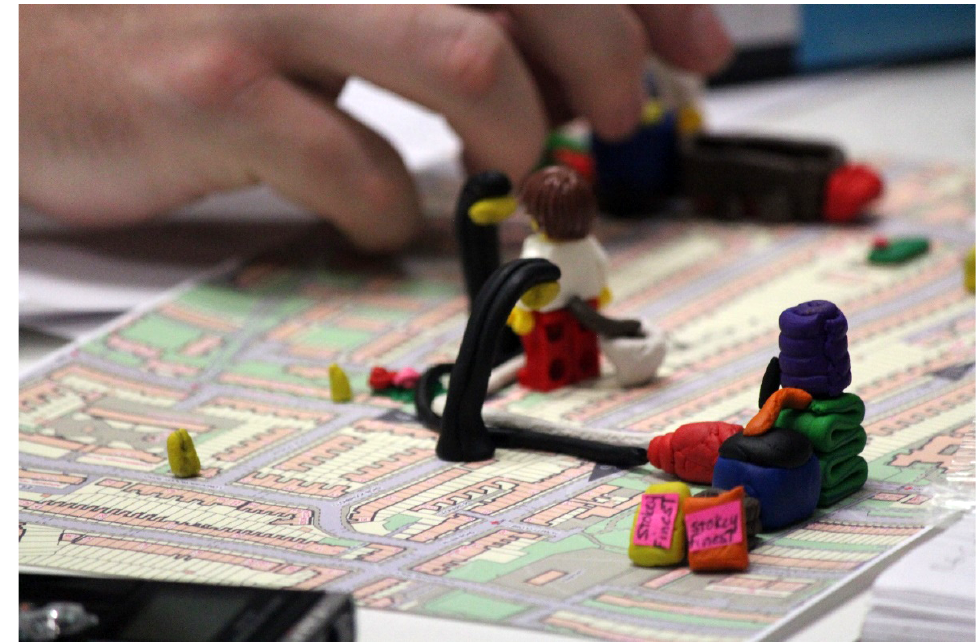
Figure 3. “Silvia Does a Poo” scenario. Photograph by Danielle